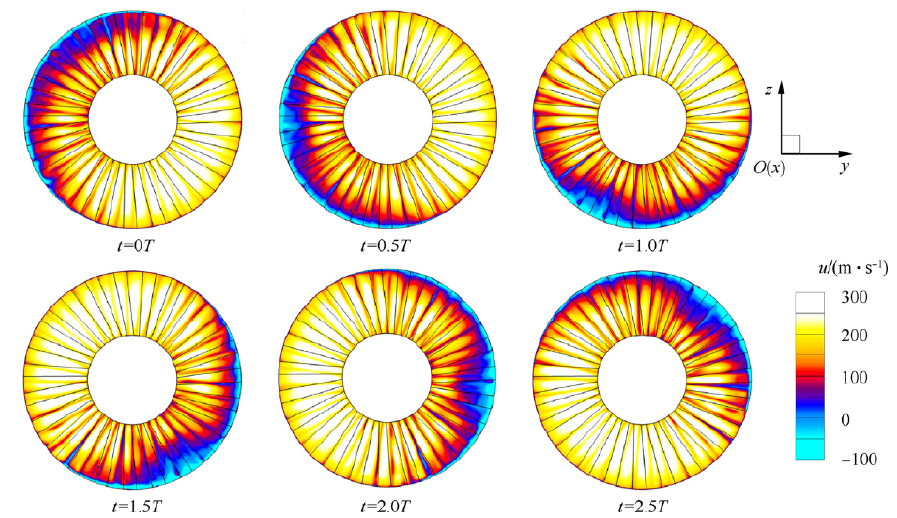
Figure 8. Axial velocity contours of a bladed disk during rotating stall. From Liang